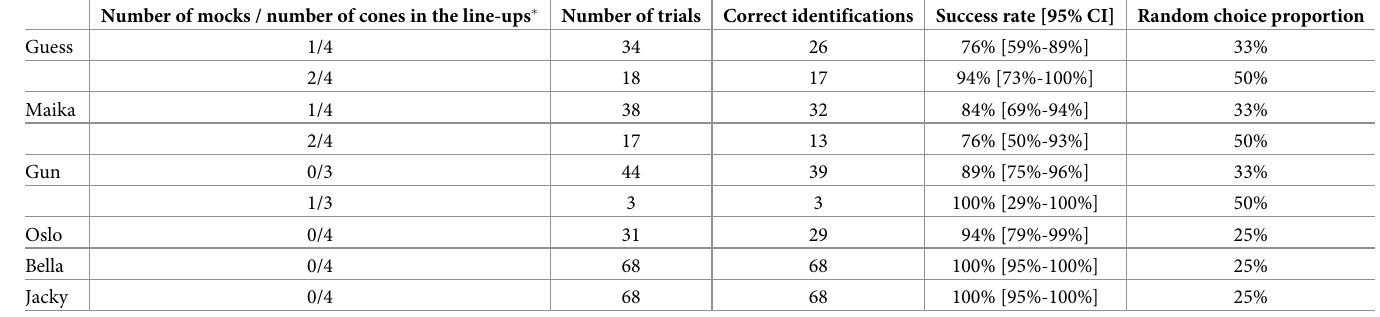
CI: Confidence interval; � All line-ups contained one COVID-19 positive sample, and at least one COVID-19 negative